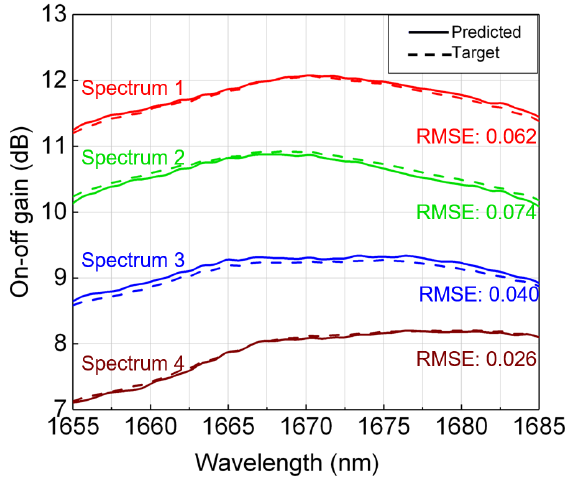
Figure 5. The results of four kinds of gain spectrum profiles.